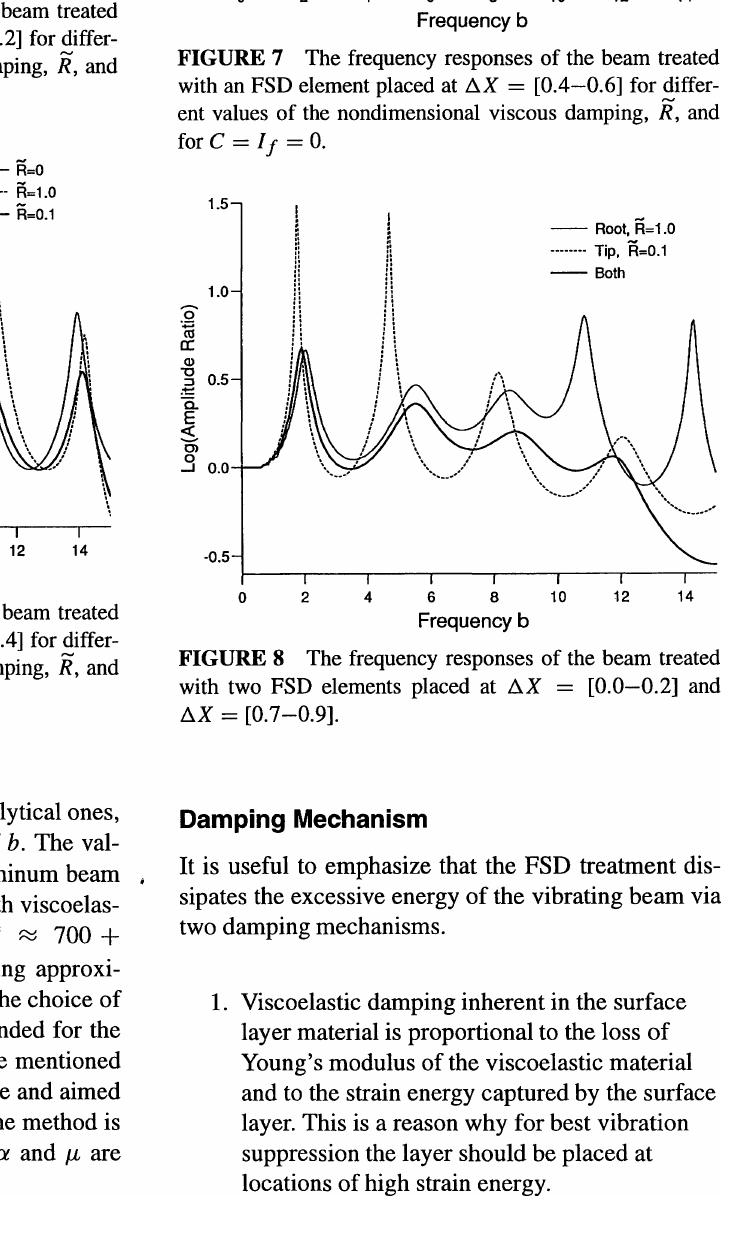
FIGURE 5 The frequency responses of the beam treated with an FSD element placed at fl.X = [0.0-0.2] for differ ent values of the nondimensional viscous damping, ii, and for C = If = O.